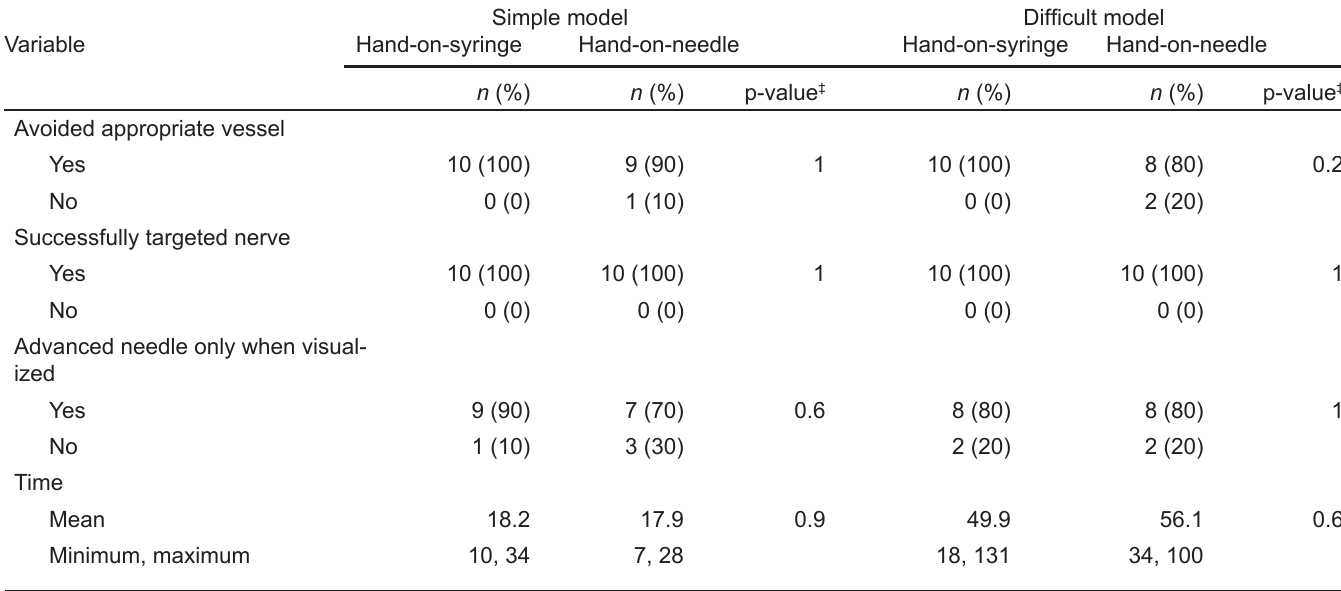
Table 2. Performance accuracy using hand-on-needle versus hand-on-syringe technique* for ultrasound-guided regional anesthesia on a simulation model.